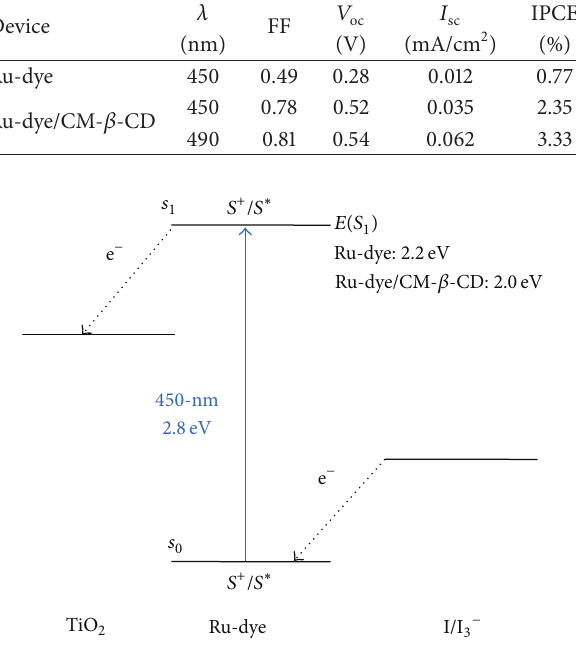
Figure 7: Energy diagrams of the Ru-dye-containing and Ru- dye/CM- 𝛽 -CD-containing devices showing the ground and excited states of the